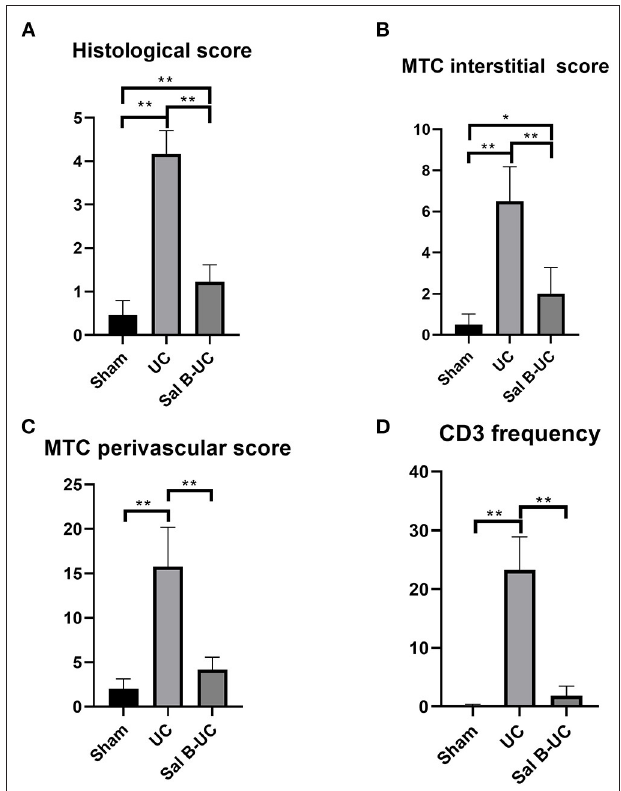
FIGURE 2 | Pathology score evaluation. (A) The histological score in the UC group was significantly higher than in the other groups. (B) Fibrosis intensity in the UC group was more than in the Sham and Sal B-UC groups as indicated by the blue staining of Masson’s trichrome score. (C) Fibrosis in the perivascular area in the UC group was also high. (D) CD3 + T-lymphocyte frequency in the UC group was the highest among the three groups. The * symbol indicates the significant difference of p < 0.05. The ** symbol indicates the significant difference of p < 0.01.